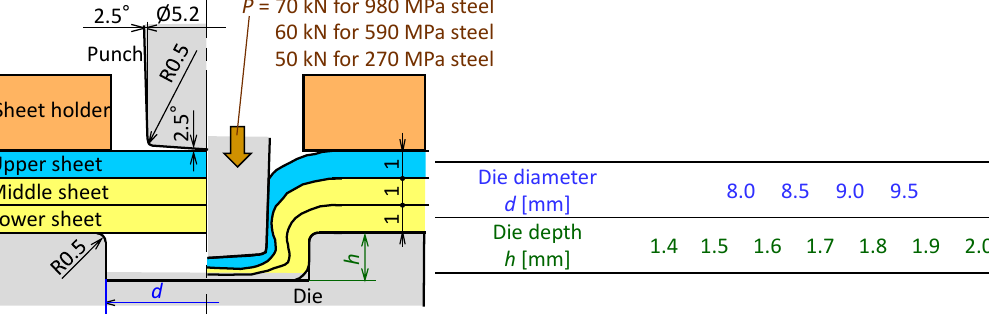
Figure 17. Mechanical clinching conditions of three sheets.